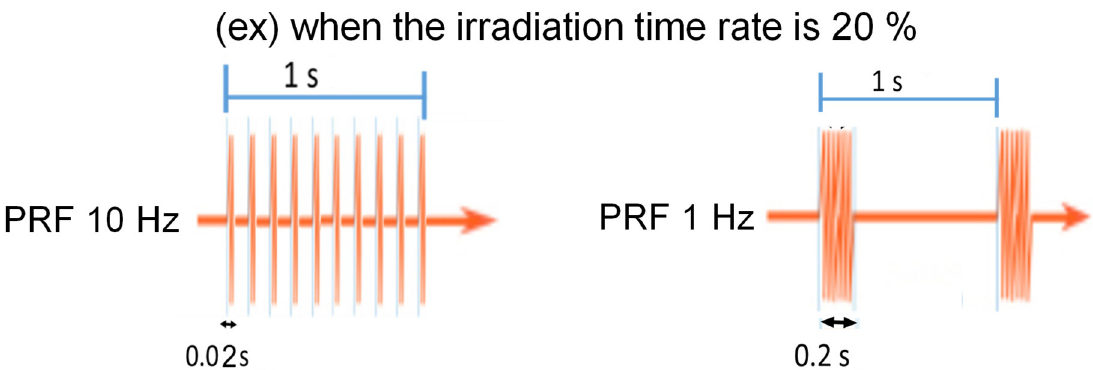
Figure 1. Ultrasound and pulse repetition frequency (PRF). PRF is the number of pulses of output per second in US waves. When the irradiation time rate is the same, the PRF is lower, and the longer the pulse per